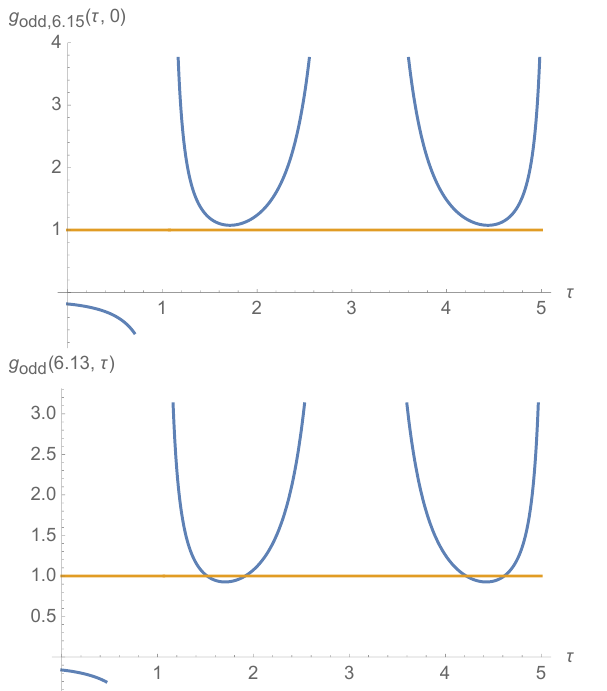
Figure 8. A plot g odd ( (cid:28) ) and 1 for d = 6 : 15 (top) and d = 6 : 13 (below) indicating that some eigenvalues become real below d < 6 :